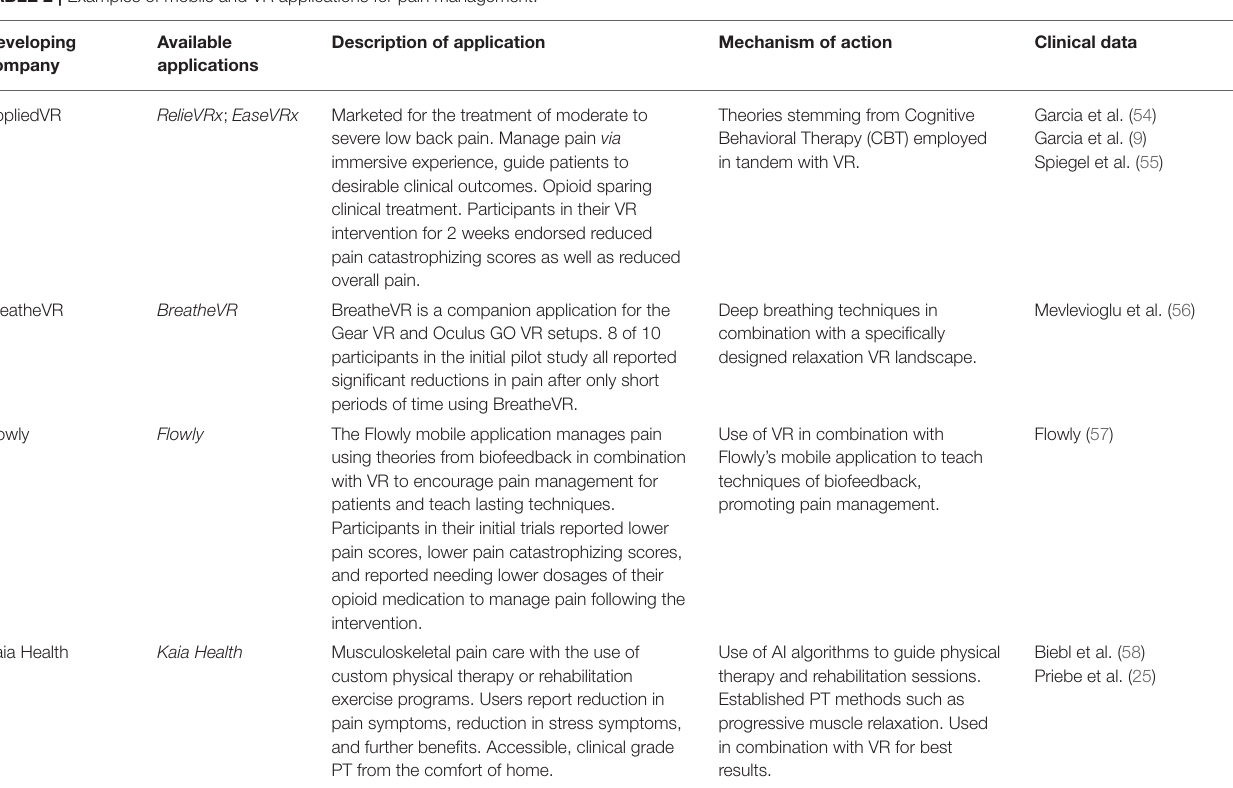
TABLE 2 | Examples of mobile and VR applications for pain